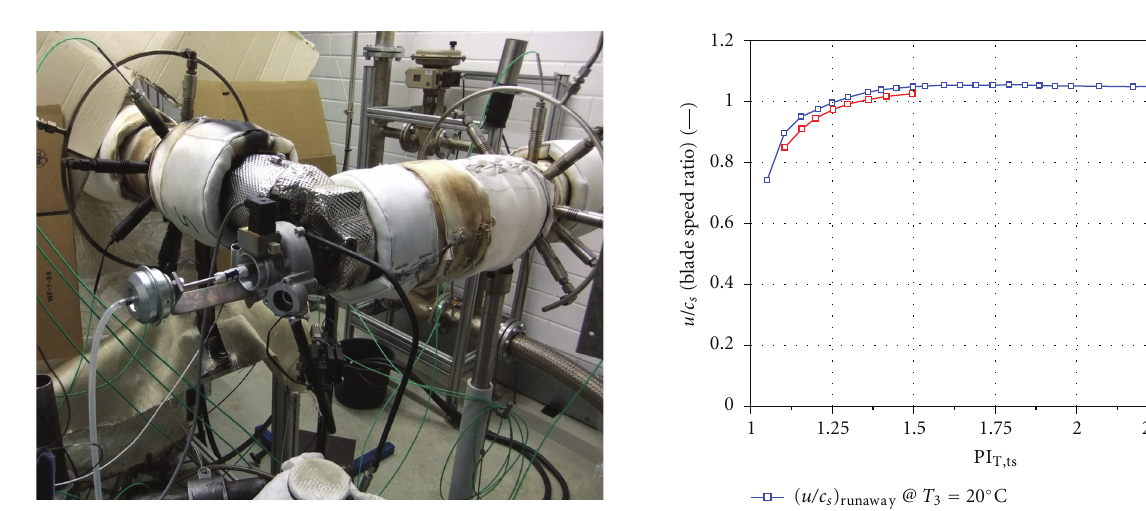
Figure 13: High inertia rotor (HIR) assembly.